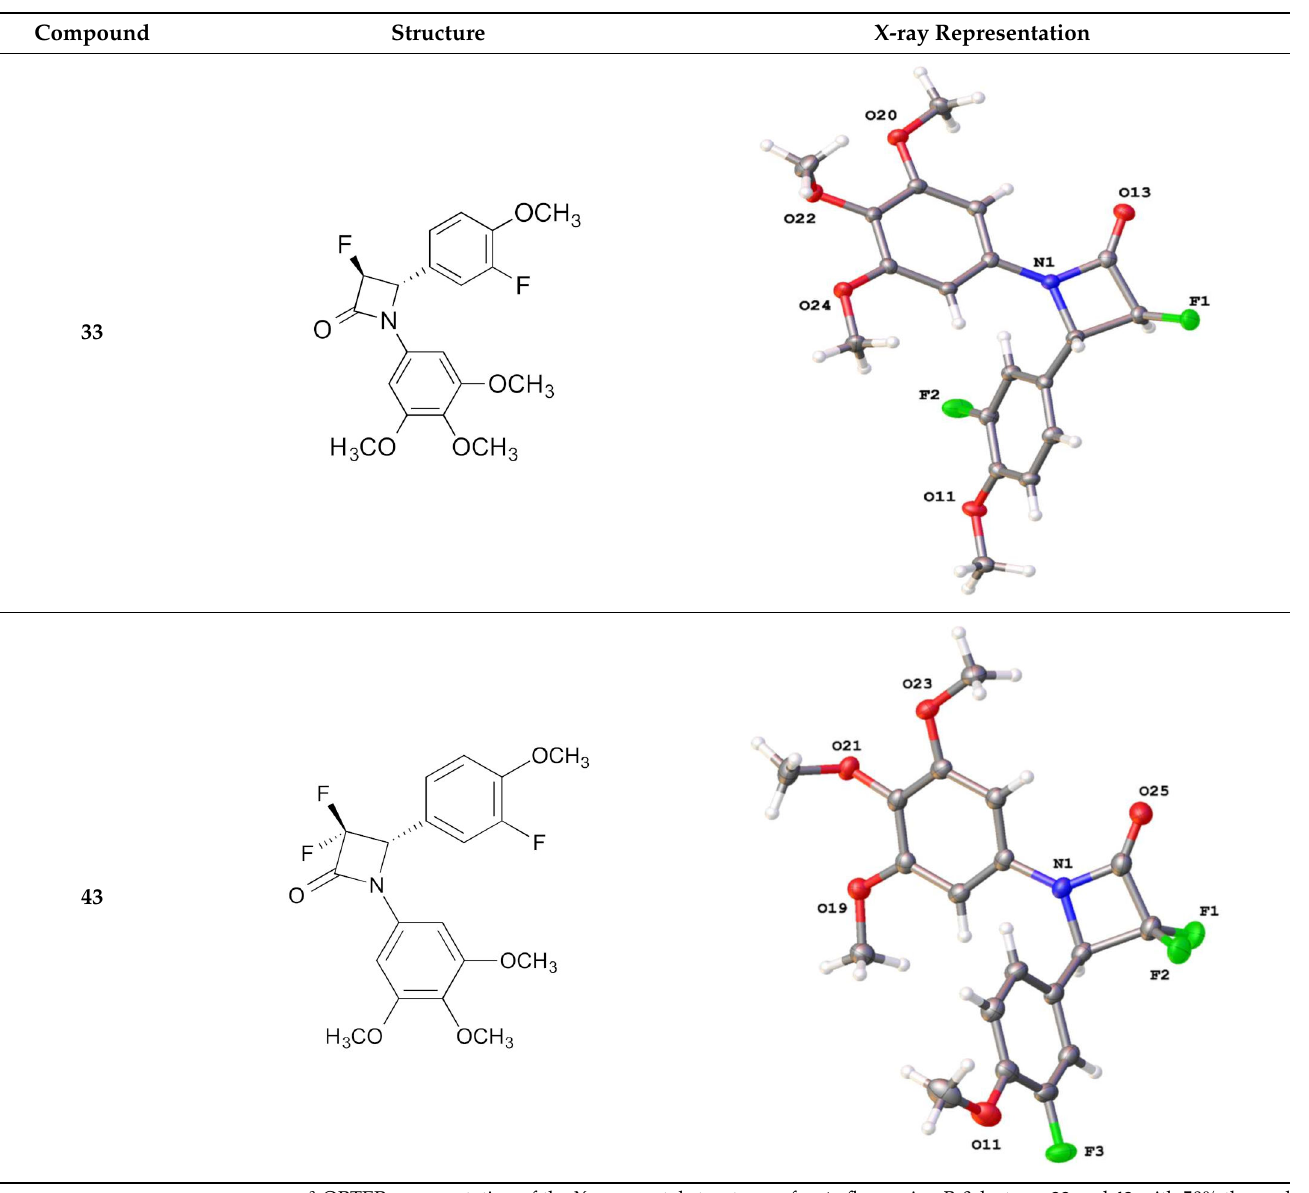
Table 2. X-ray crystal structures of β -lactams 33 and 43 a